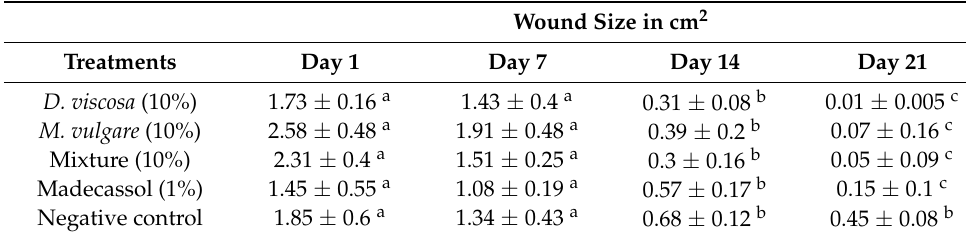
Table 3. Wound size in cm 2 of each group of rats from day 1 till day